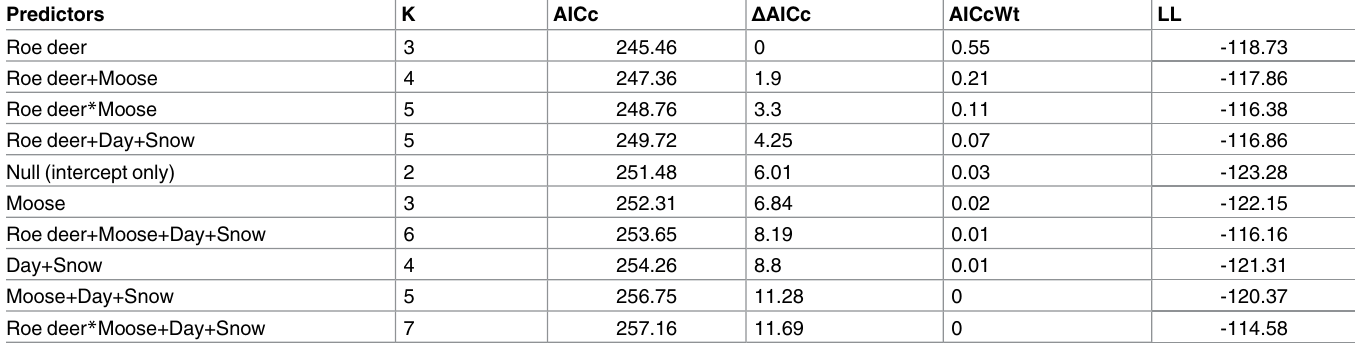
Table 2. Generalised linear mixed models (binomial logit) describing the Scandinavian wolves’ selection of roe deer (1) as prey over moose (0) as a function of local roe deer density (Roe deer), local moose density (Moose), winter day number (Day) and snow depth (Snow). Wolf territory is includedas a random factor and the number of parameters in the model is indicatedby K , AIC corrected for small sample size AIC c , differences betweenmod- els Δ AIC, the model weights AIC c Wt, and the log likelihood value for each model LL.